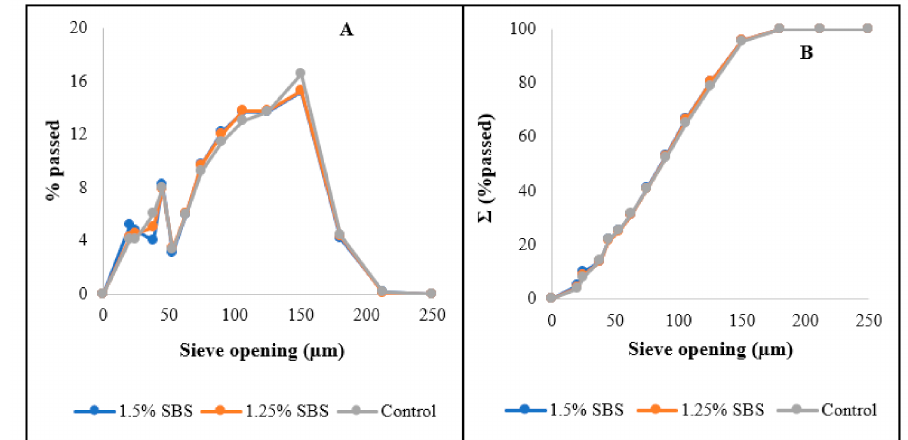
Figure 2. Particle size distribution ( A ) and cumulative particle size distribution ( B ) of wheat flours; control corresponds to 0% SBS tempering treatment.